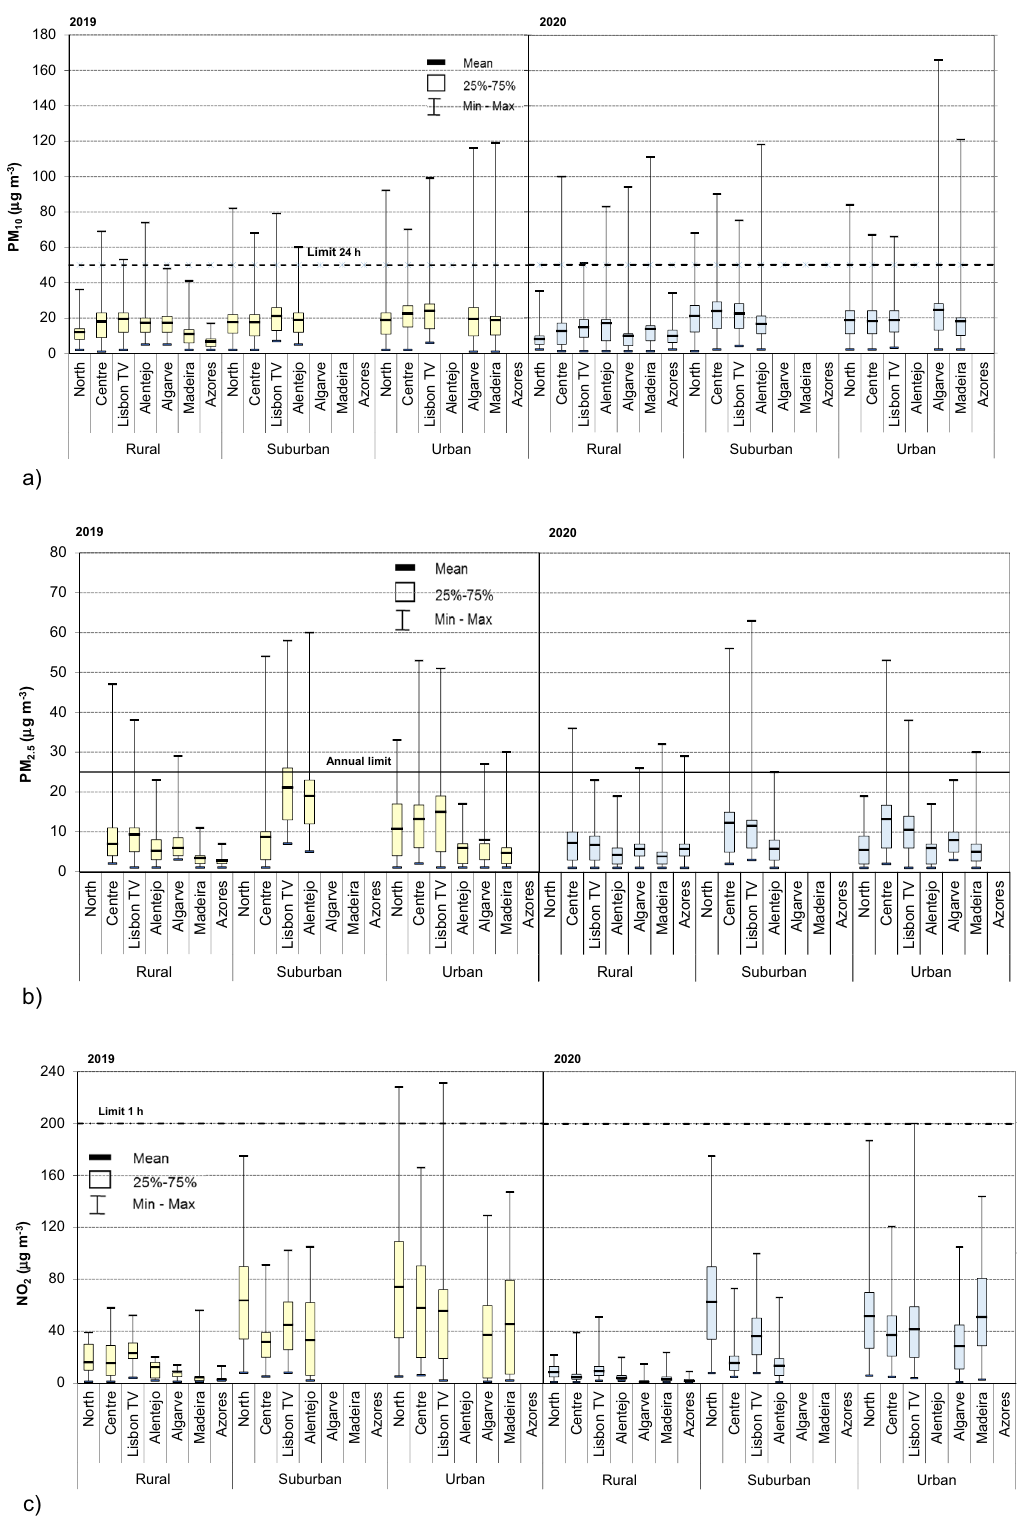
Figure 1. Concentrations of particulate and gaseous air pollutants (closed square, median; open square, 25–75%, and range) in (January–May) 2019 and 2020 in Portugal, ( a ) PM 10 ; ( b ) PM 2.5 ; ( c ) NO 2 ; ( d ) SO 2 ; and ( e ) O 3 . Notes: Horizontal dashed lines represent the 1 h and 24 h standards as defined in Directive 2008/50/EU 31 . For PM 2.5 horizontal line represents annual limit. Distributions of each pollutant were significantly different ( p < 0.05) across the three zones and emissions sources. The concentrations of PM are expressed as 24 h averages whereas the gaseous pollutants are expressed as 1 h maxima. For better visualization vertical axis y uses different